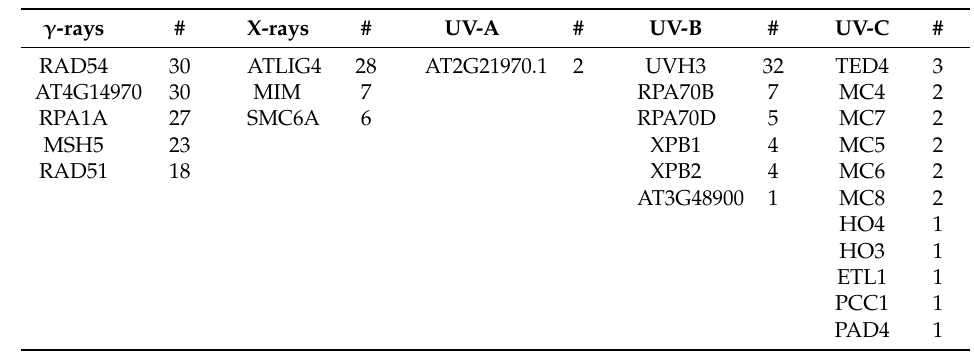
Figure 3. Detail of the protein-protein interaction network, created using STRING V.10.0, where the 237 A. thaliana selected by the previous step genes were set as input. The network was rearranged in order to better identify some of the key genes. Table 2. Selected genes the products of which would serve as ‘exclusive’/highly specific biomarkers for the identification of radiation quality in planta, and therefore as specific indicators of the geographical region in which the ‘biosensor plant’ lives. These genes encode products that appeared as nodes of dense cliques of a protein-protein interaction network, created using STRING v10 (Figure 3). Genes are listed, along with a number, indicative of the multiplicity of their orthologues across the plant species under study. The symbol ‘#’ indicates the number of species.